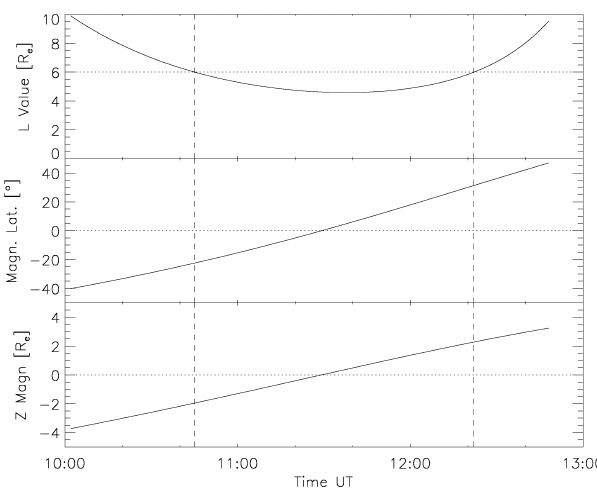
Fig. 12. Characteristics of a typical Cluster orbit. For 24 October 2004 the L value (top panel), magnetic latitude (middle panel) and distance from the magnetic equator (bottom panel) are